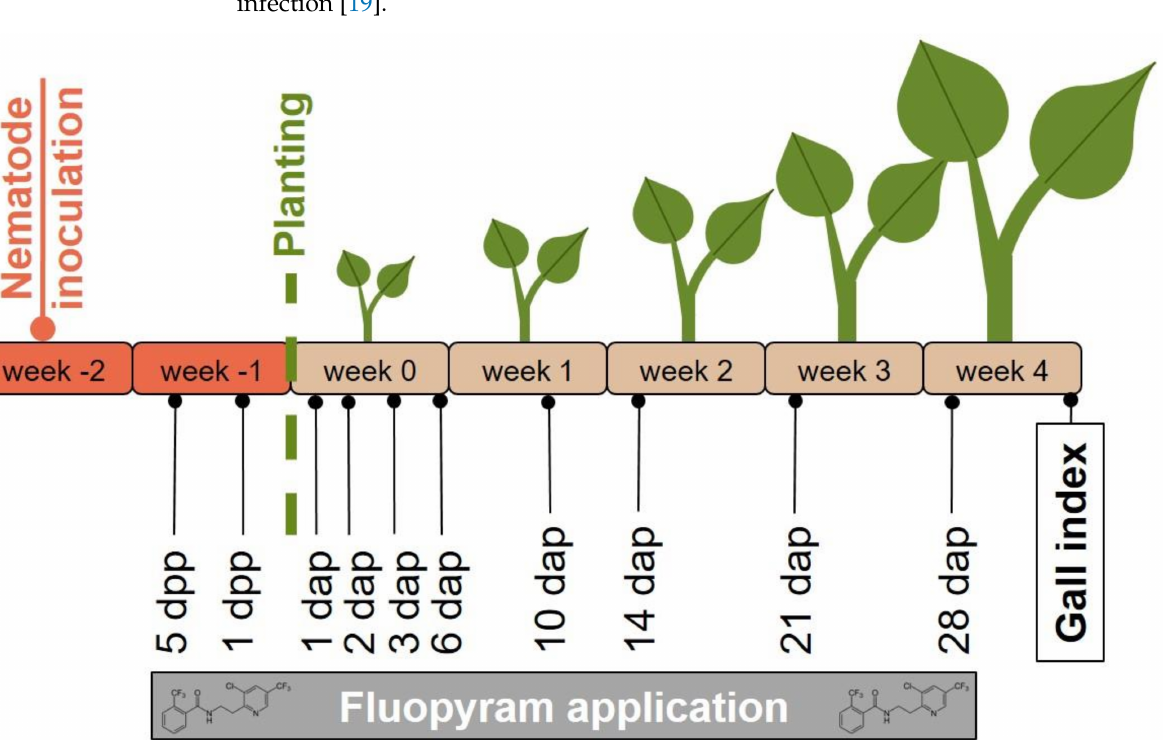
Figure 1. Schematic representation of fluopyram application at different time points to assess the control of Meloidogyne incognita in soil and plant